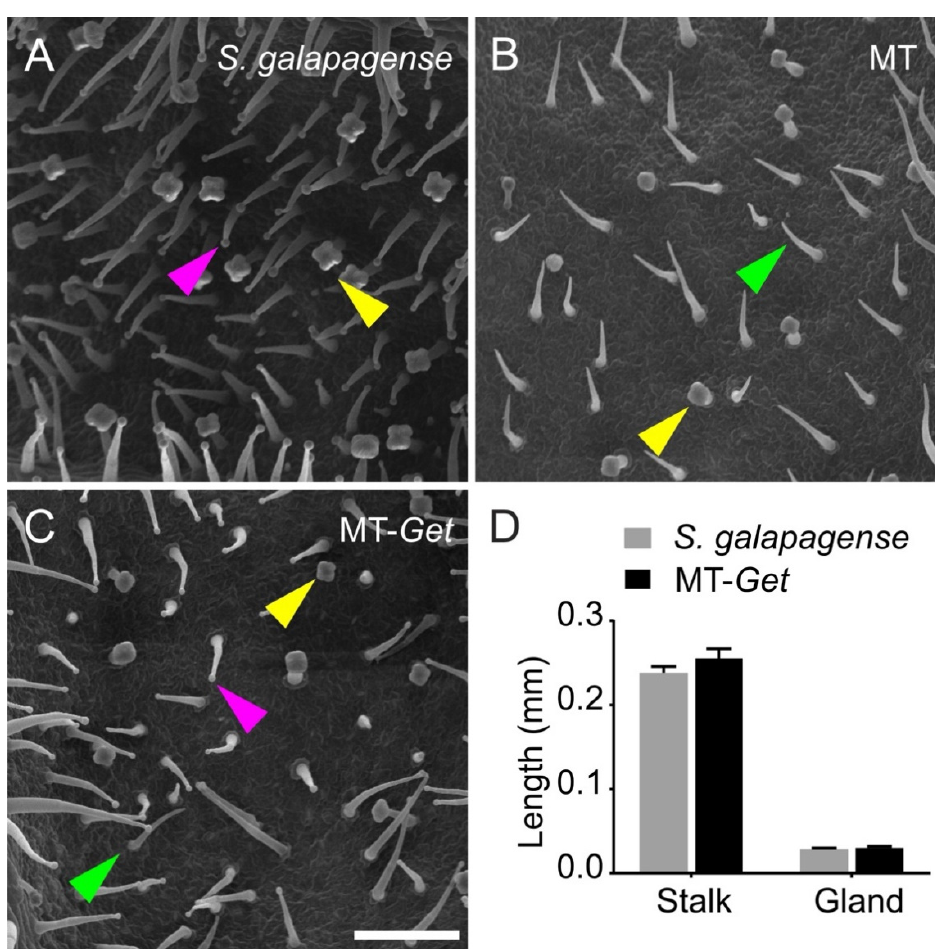
Figure 2. Scanning electron micrographs of abaxial sides of the fifth leaf of representative 25-day- old plants of the tomato wild relative Solanum galapagense LA1401 ( A ), Micro-Tom ( B ), and the “ Galapagos enhanced trichomes ” genotype (MT- Get ) ( C ). Scale bar = 200 µ m. The arrowheads point to different trichomes: type IV (pink), type V (green), and type VI (yellow). ( D ) Type-IV trichome stalk and gland length comparisons between S. galapagense and MT- Get . Data are means ( n = 30) ± SEM. The data are not statistically different according to Student’s t -test ( p < 0.05 threshold).